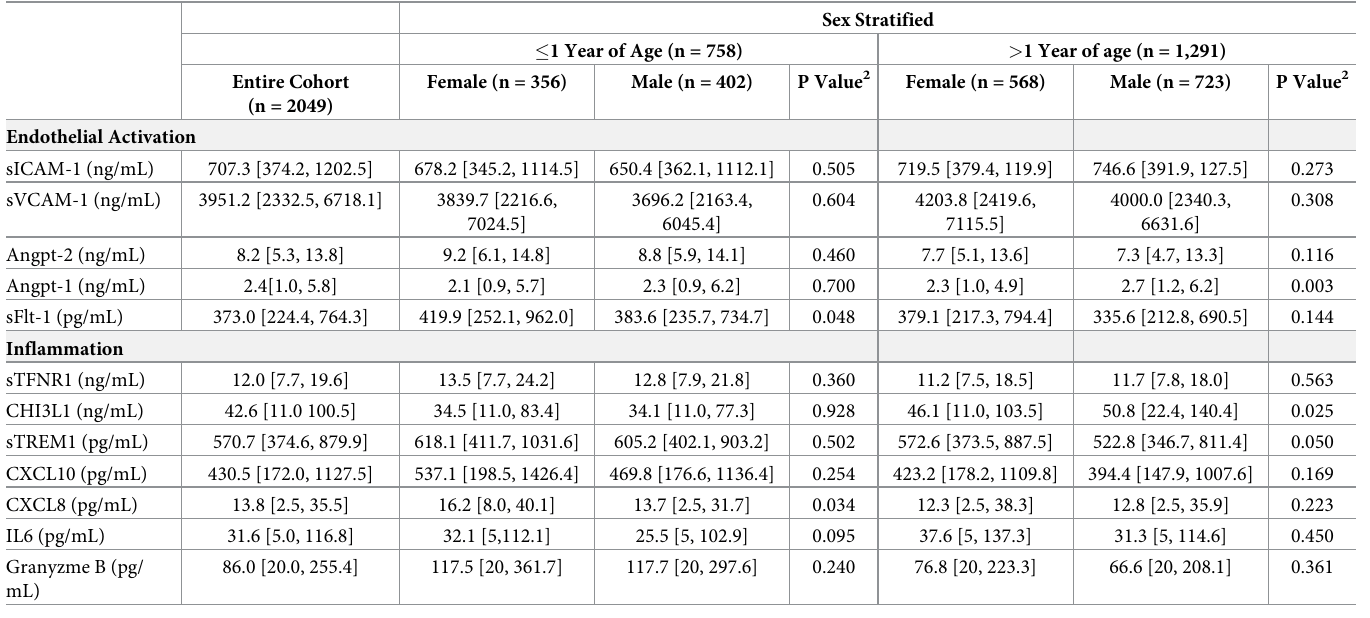
Table 4. Analyte concentrations in children with known outcome stratified by